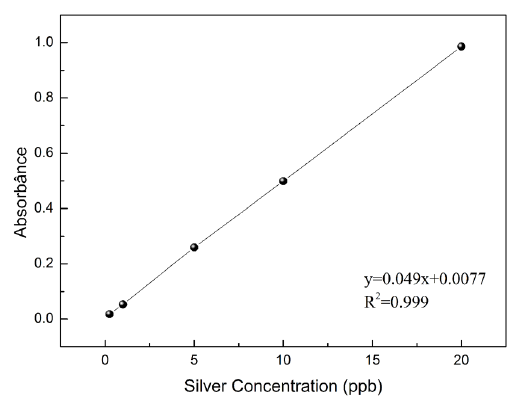
Figure 4. Calibration curve for concentration of silver solutions determination from atomic absorption